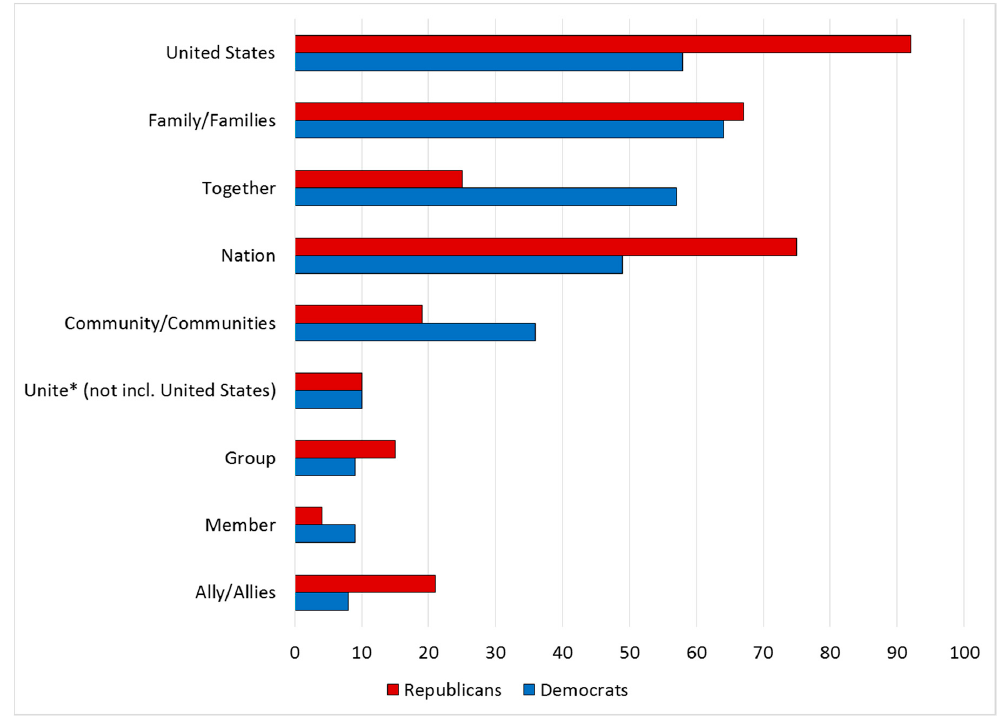
Figure 2. The most frequently spoken Ingroup-Virtue words, by party. Note: the horizontal axis represents the total number of mentions of each word, across all segments where at least two Ingroup-Virtue words appear (n = 106 Republican and 100 Democratic segments).